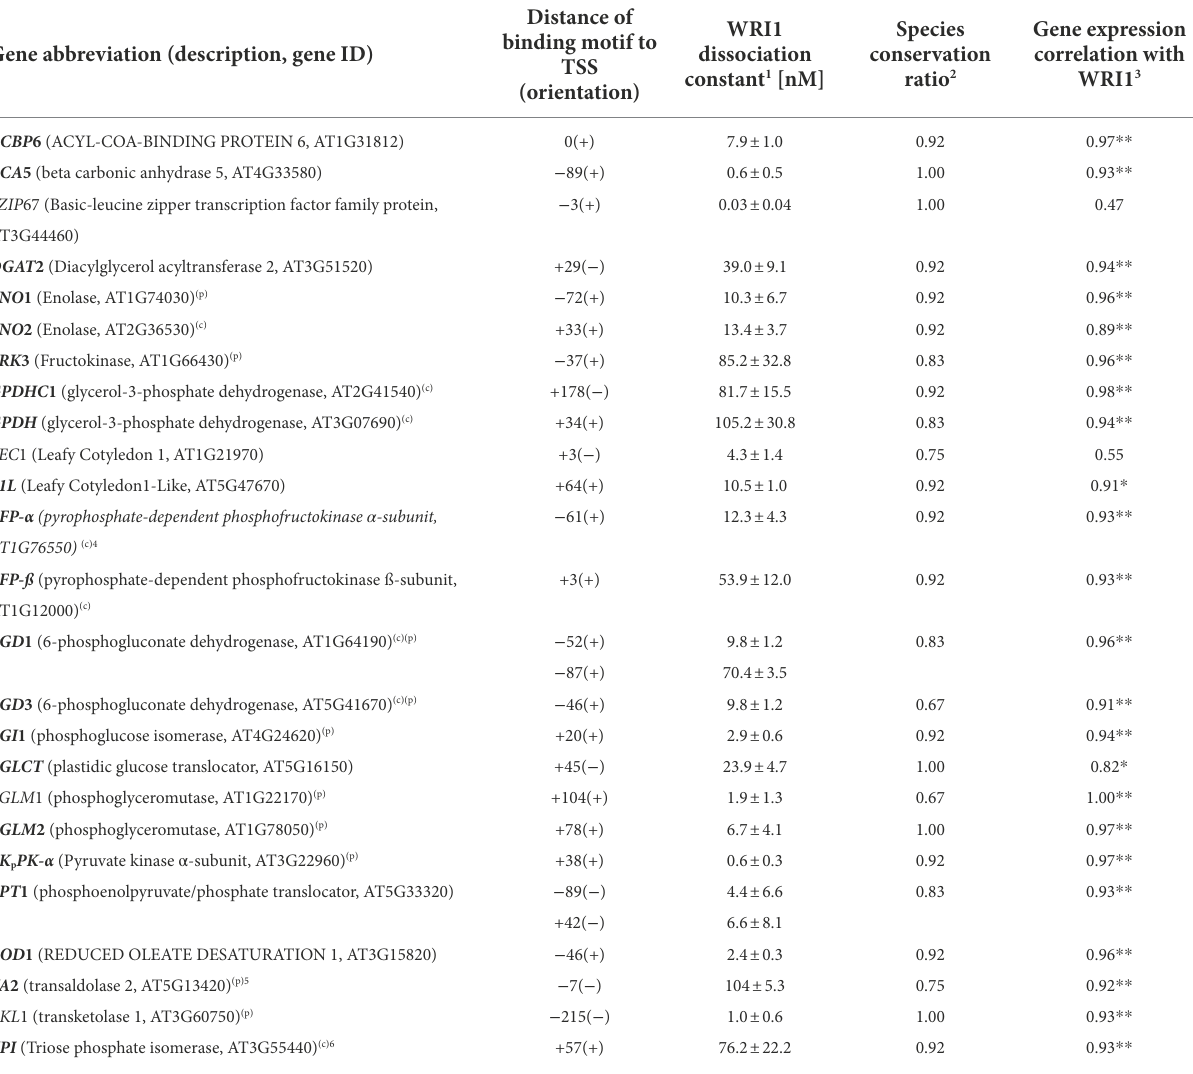
TABLE 6 Putative direct A. thaliana WRI1 regulatory gene targets.